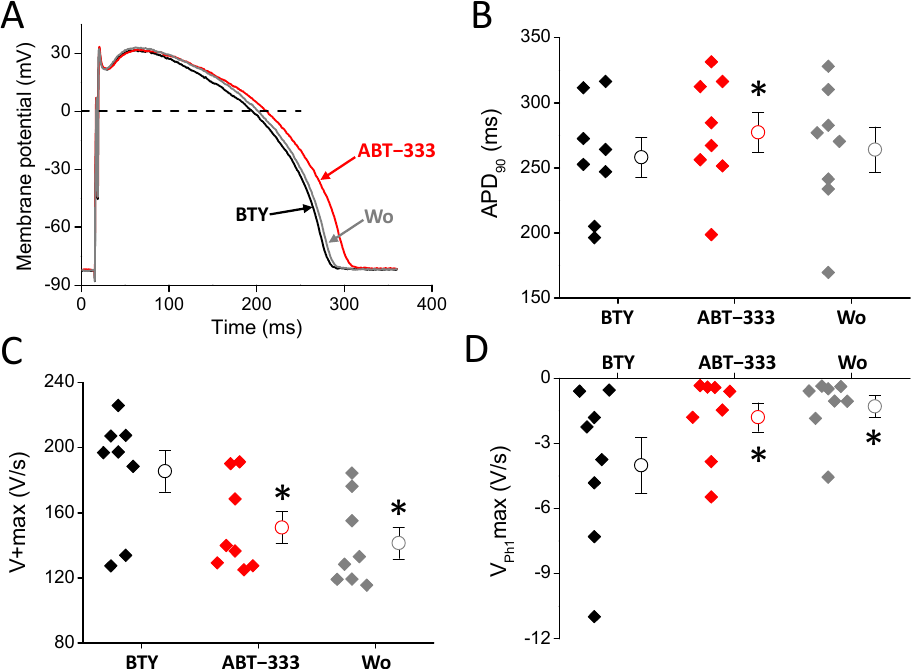
Figure 2. Effects of 1 µ M ABT-333 on left ventricular AP. ( A ) Representative action potentials. The black trace is the AP measured in BTY (control solution), the red is the presence of 1 µ M ABT-333, while the gray is after washout. ( B – D ) Diagrams showing AP parameters in control condition (BTY, black), in the presence of ABT-333 (1 µ M, red) and after washout of ABT-333 (grey) where filled diamond symbols, circles, and whiskers show the individual values, means, and ± SEM, respectively. Values of action potential duration measured at 90% of repolarization (APD 90 , ( B )), maximal rate of depolarization (V + max, ( C) ), and maximal rate of early repolarization (V Ph1 max, ( D) ) obtained in 8 examined cells isolated from 4 animals. Asterisks show statistically significant difference from control ( p < 0.05).